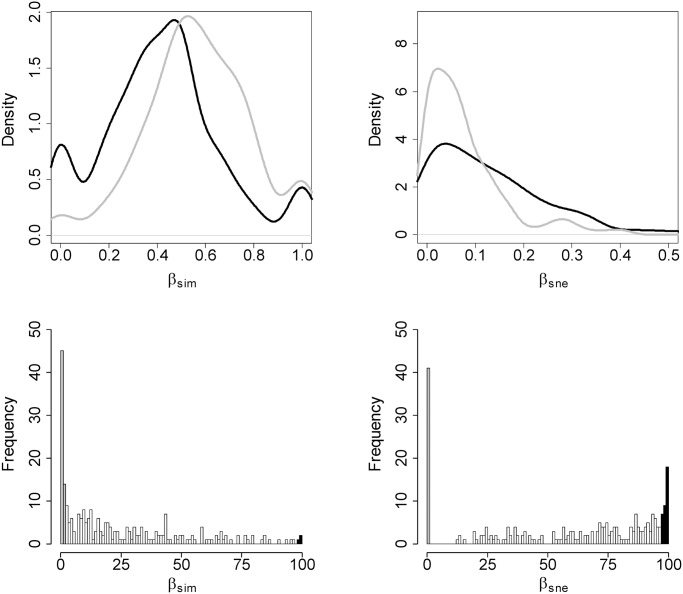
Observed patterns of temporal beta diversity against null expectations.(a) and (b) show the comparison between the distribution of observed temporal dissimilarities (1982 vs. 2007, black) and the distribution of null temporal dissimilarities (1982 vs. null assemblages, gray), for the turnover (βsim) and nestedness-resultant (βsne) components, respectively. (c) and (d) show the frequency distribution of sites for which the observed temporal turnover is significantly lower (gray) or higher (black) than the null expectation (random reshuffling of the regional pool fixing species frequencies).